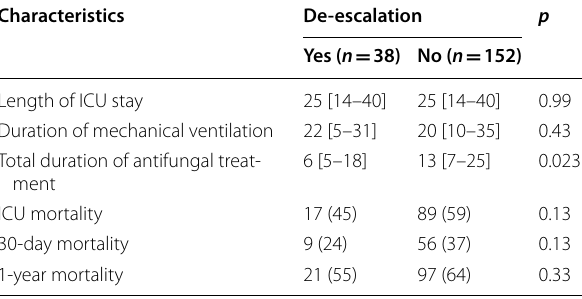
Data are N (%), or median (interquartile range)